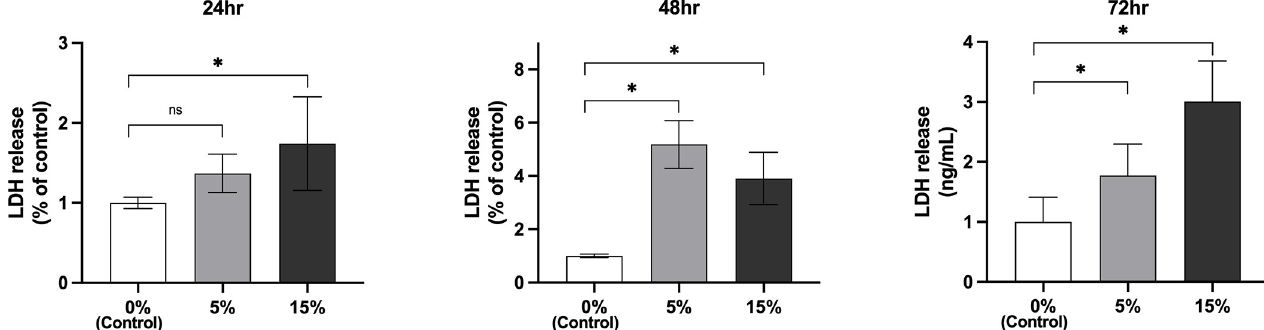
Fig 5. Cytotoxicity assay of ligamentum flavum cells. MSS loading at 5% stretch for 24 h on ligamentum flavum cells did not significantly affect the LDH release level. Stronger stretch (15%) and stretching for 48 h resulted in significantly increased LDH levels, indicating a cytotoxic effect.